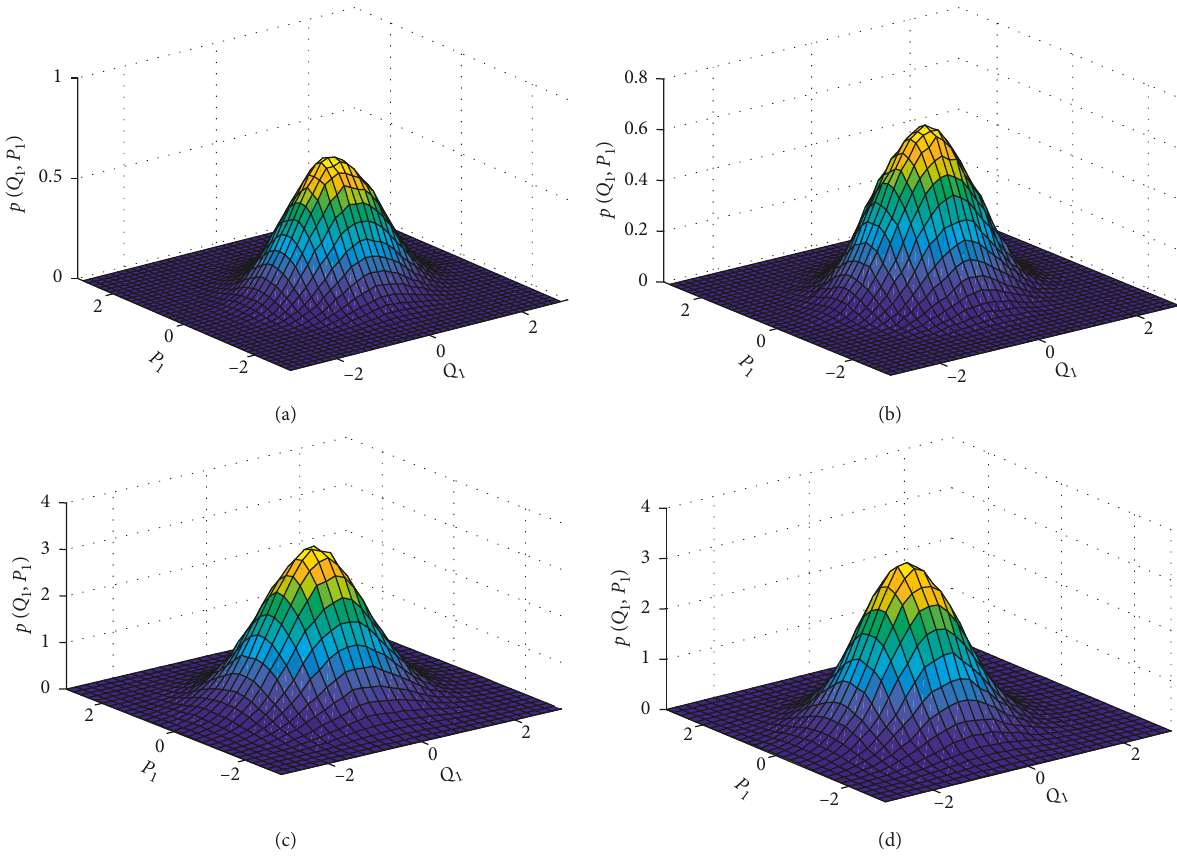
Figure 1: The stationary joint probability density p u ( Q controlled system: (a, c) results by the proposed method; (b, d) results by Monte Carlo simulation of the original system